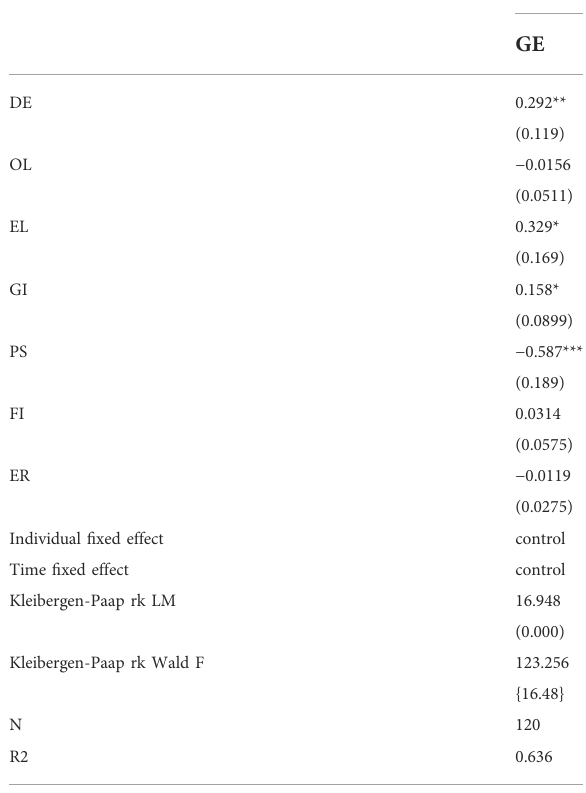
TABLE 7 Robustness test